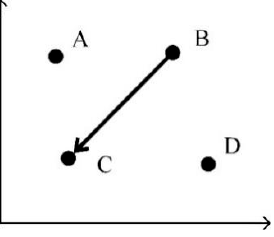
Figure 2. The schematic diagram of the monitoring site location.